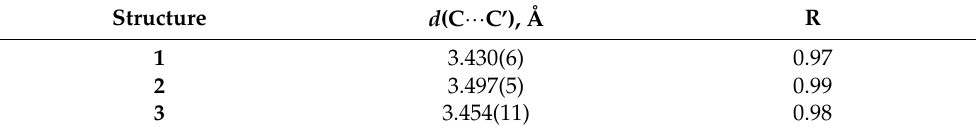
Table 5. Characteristic parameters of C ∙∙∙ C’ contacts involving CNR species in 1 – 3 .